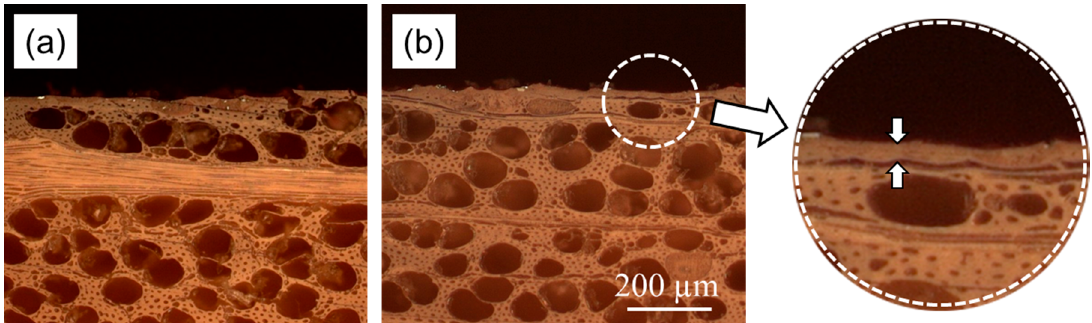
Figure 8. Representative light-microscopic images of cross sections of beech wood treated with ( a ) linseed oil varnish and ( b ) linseed oil varnish modified with NFC solvent-exchanged to propylene carbonate. The inset highlights the oil film obtained using this modified oil formulation.